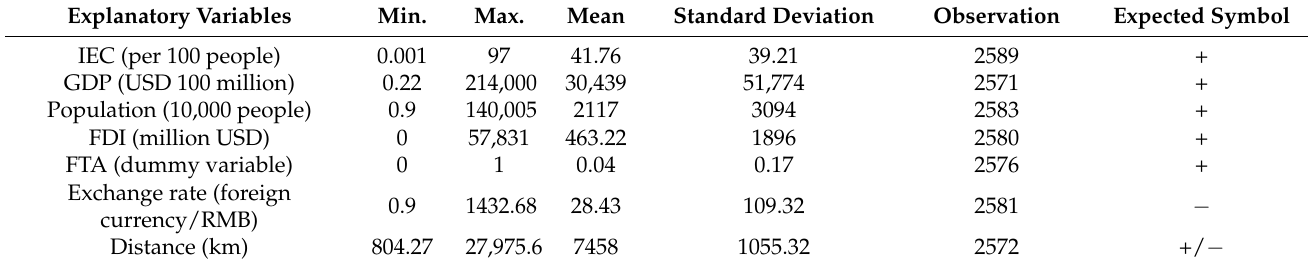
Table 1. Description of the main explanatory variables.